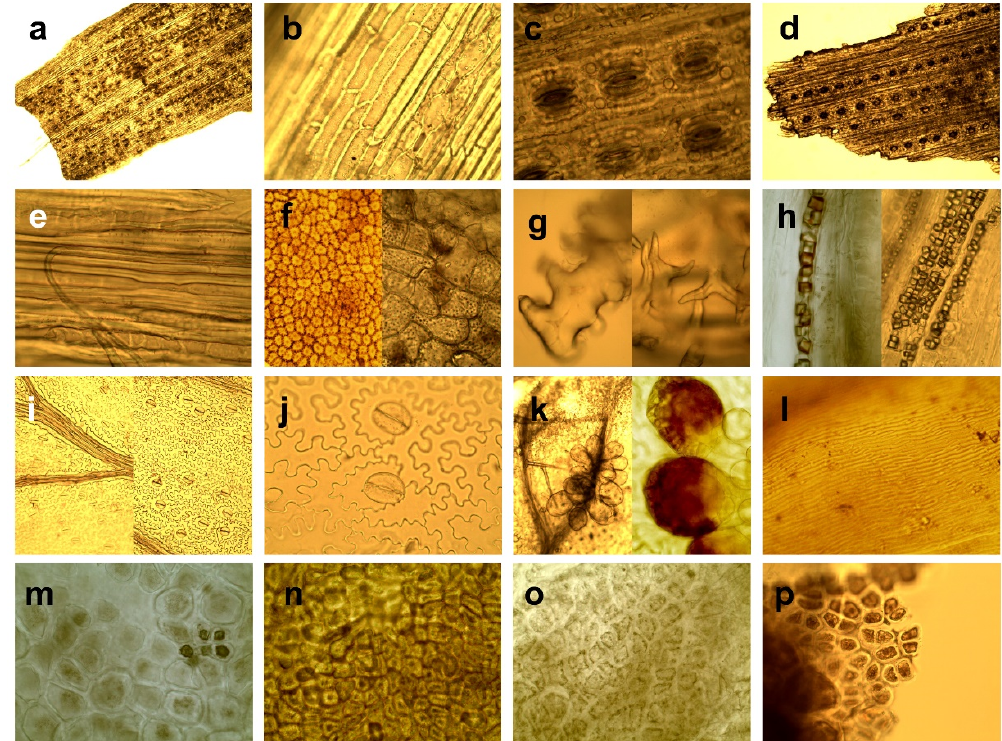
Figure 2. ( a ) elongated epidermal cells regularly arranged in rows on fragment of needle of Abies alba (40×); ( b ) cell wall more less at right angle to the long axis of the cell on fragment of needle of Picea abies (400×); ( c ) guard cells of stomata are deeply sunken below the surface of other epidermis on needle of Pinus nigra J. F. Arnold, (400×); ( d ) stomata arranged in rows on needle of Pinus nigra , (100×); ( e ) fibers of wood from Prunus spinosa L. (400×); ( f left ) cork cells of bark from Pinus nigra (400×); ( f right ) cork cells of bark from Picea abies , abx (400×); ( g left , right ) branched sclereids of bark from Abies alba (400×); ( h ) crystals in large quantities Abies alba, (400×); ( i left ) fine structure fragment with open venation on leaf of Athyrium filix-femina , adx (100×); ( i right ) stomata aligned with leaf veins of Dryopteris filix-mas , abx (400×); ( j ) Mnium type of stomata on leaf of Dryopteris filix-mas , abx (400×); ( k left ) sporangia on leaf of Athyrium filix-femina , adx (400×); ( k right ) sporangia on leaf of Phegopteris connectilis (Michx.) Watt, abx (100×); ( l ) fine structure fragment of moss sp., with labyrinth-like pattern (400×); ( m ) irregularly arranged cells with a thickened cell wall and internal filling in acorn (400×); ( n ) clusters of sclereids in stone of plum (400×); ( o ) epidermal thick-walled cells on hip (400×); ( p ) irregularly arranged thick-walled cells with internal filling in beechmast (400×).